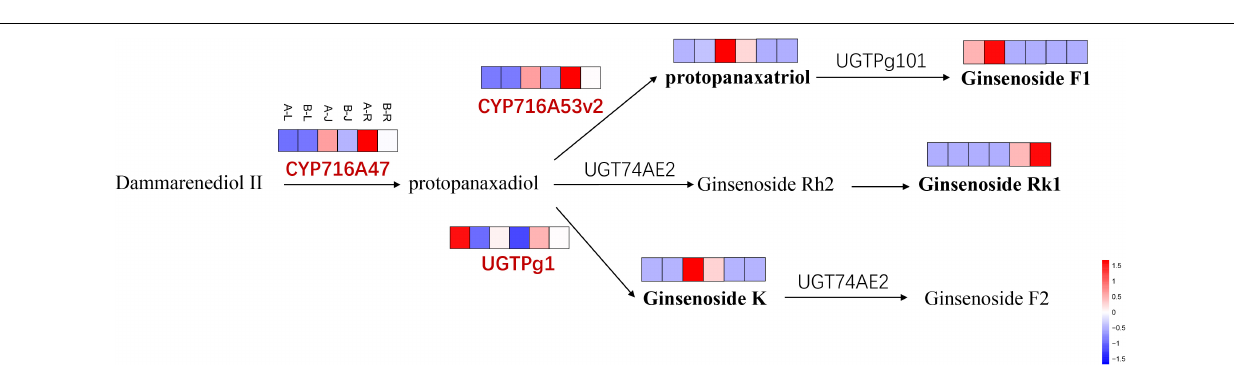
FIGURE 10 | The DEGs and DAMs involved in ginsenoside biosynthesis in response to inflorescence